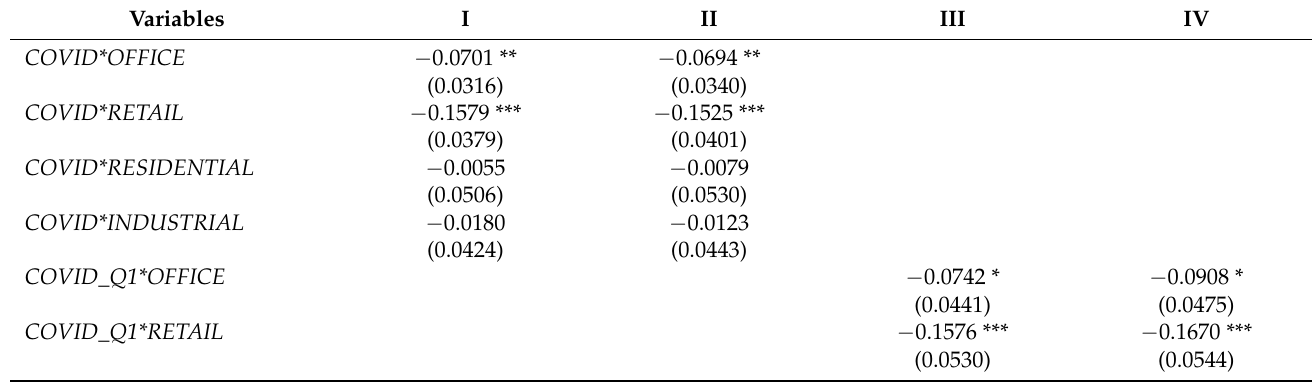
Table 5. The Impact of the COVID-19 Pandemic on Rent Dynamics by Property Types. This table presents the OLS regression estimation results of testing the impact of the COVID-19 pandemic on commercial real estate rent. The dependent variable is LOG (RENT) , the natural logarithm of rent for the specific city and property type. The independent variables of interest are the interaction terms of COVID, COVID_Q1 and COVID_Q2 with the property type dummies. All variables are described in Appendix A. The standard errors are reported in parentheses. ***, **, and * denote significance of the t-statistics at the <1%, 5% and 10% levels,